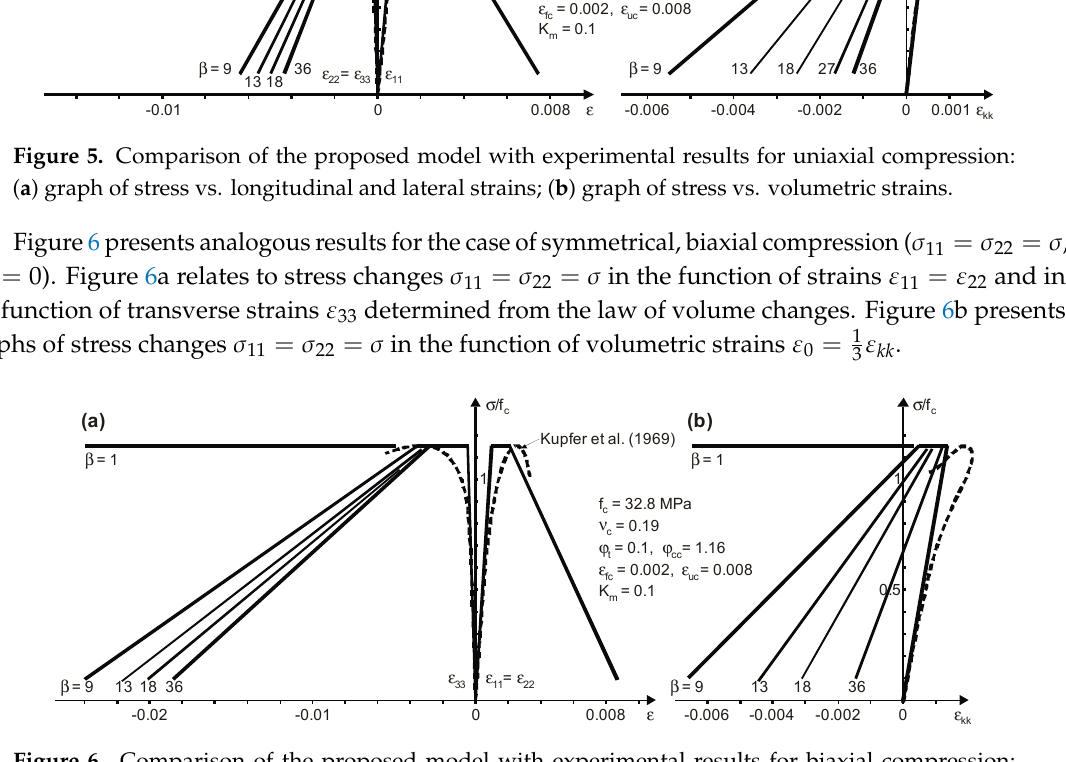
Figure 5. Comparison of the proposed model with experimental results for uniaxial compression: ( a ) graph of stress vs. longitudinal and lateral strains; ( b ) graph of stress vs. volumetric strains. The variability of the presented stress–strain curves is characteristic for the introduced model.